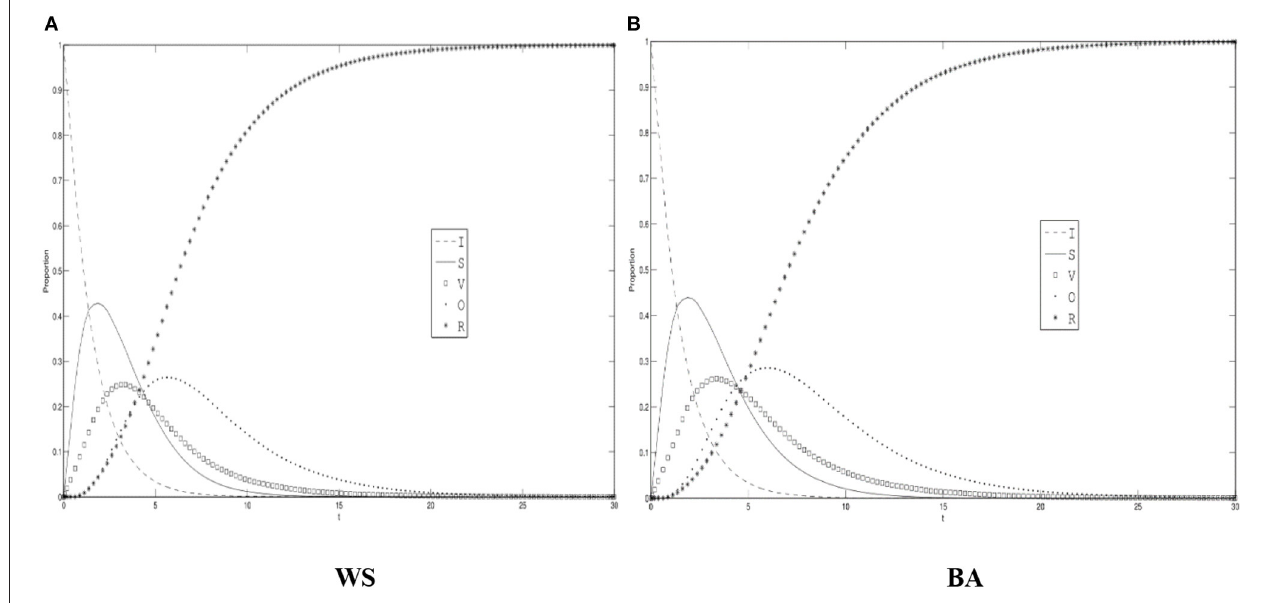
FIGURE 3 | The differences of role density in WS small world and BA scale-free network. (A) WS, (B)